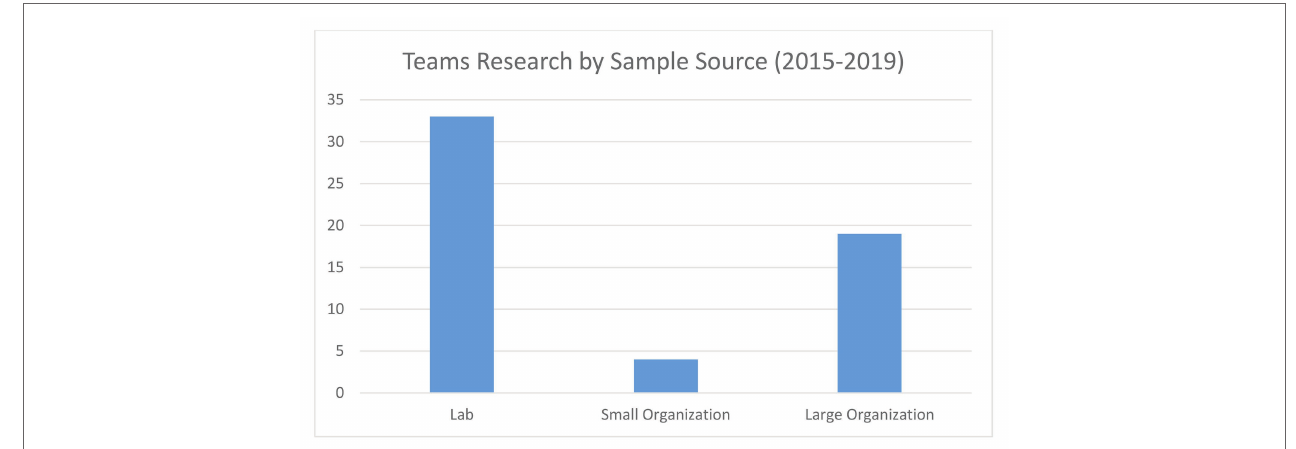
FIGURE 1 | Teams research articles by sample source type comprised of 2015–2019 literature.